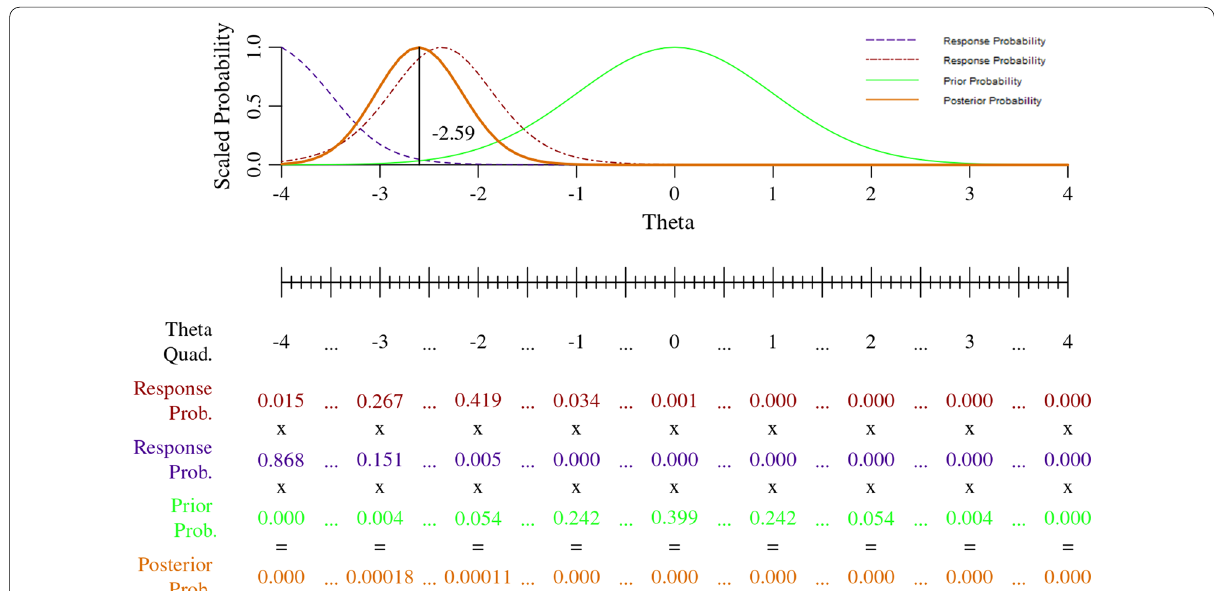
Fig. 8 Expected A Posteriori scoring with multiple PROMIS Physical Function